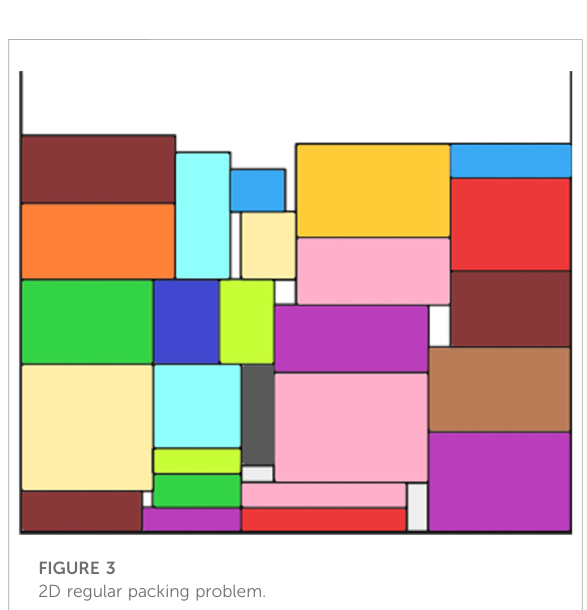
FIGURE 3 2D regular packing